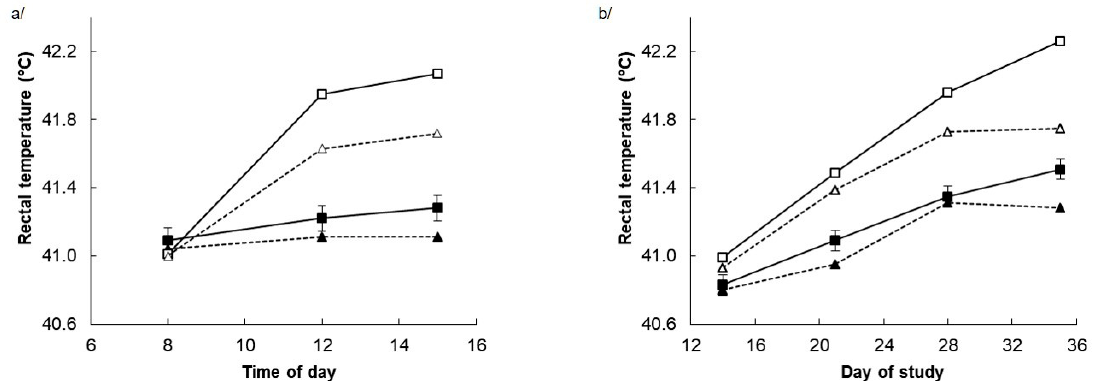
Figure 1. Rectal temperature in chickens fed either a control diet (CON, squares) or the CON diet plus betaine (BET, triangles) under either thermoneutral (filled symbols) or cyclic heat stress (open symbols). Panels ( a ) indicates the e ff ect of time of day (TM) pooled across days of the experiment (DAY) with the standard error of the di ff erence (SED) for the interaction between TM, environmental temperature (T) and diet (D) displayed on the data from the chickens receiving the CON diet. Panels ( b ) indicates the e ff ect of DAY pooled across TM with the SED for the interaction between DAY, T and D displayed on the data from the chickens receiving the CON diet. There were main e ff ects ( p < 0.10) of T ( p < 0.001), DAY ( p < 0.001), TM ( p < 0.001) and D ( p < 0.001) and interactive of T × DAY ( p < 0.001), T ×